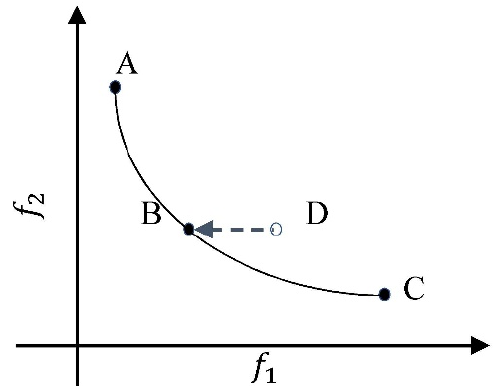
Figure 5. Pareto frontier for two objective functions of the minimization problem.